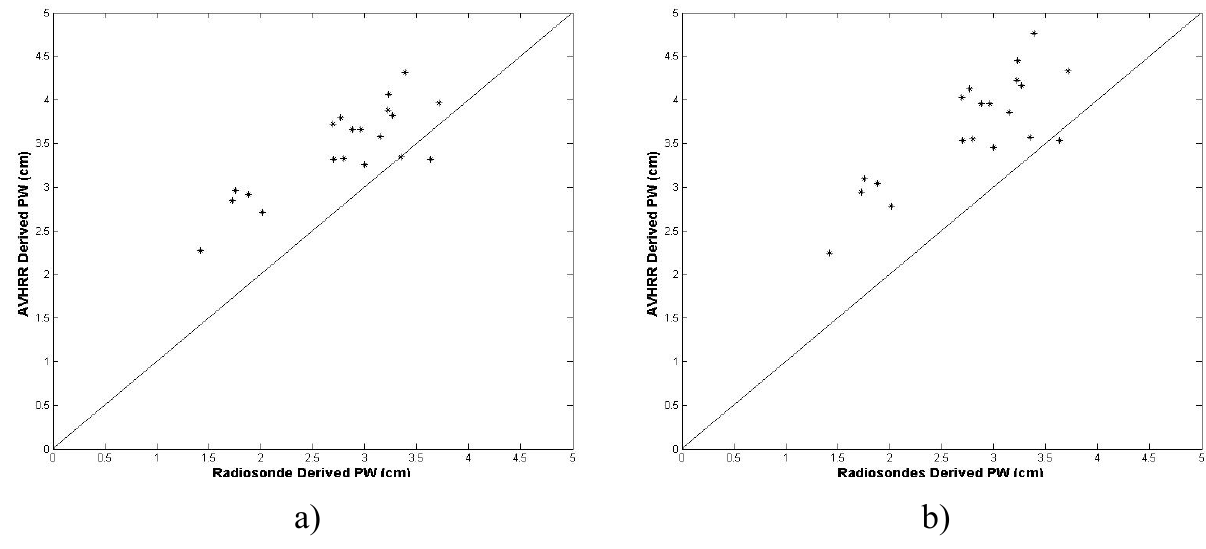
Fig. 3. Scatterplots of radiosonde derived PW versus AVHRR derived PW, estimated for cloud free cells corresponding to the synoptic station of Athalassa, (a) using the relationship formulated for the study area and (b) using the relationship formulated for the broader area of Greece.